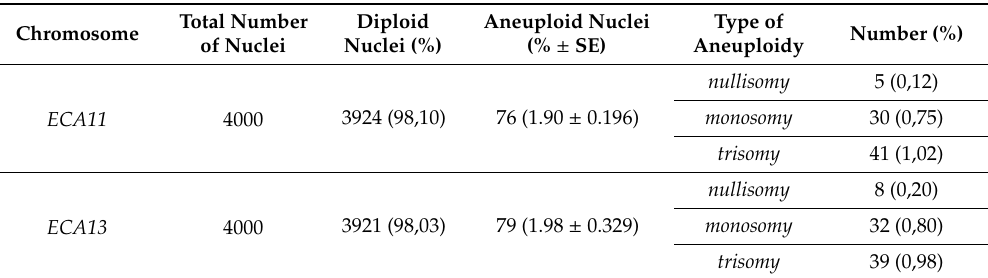
Table 1. Interphase FISH under normal conditions.